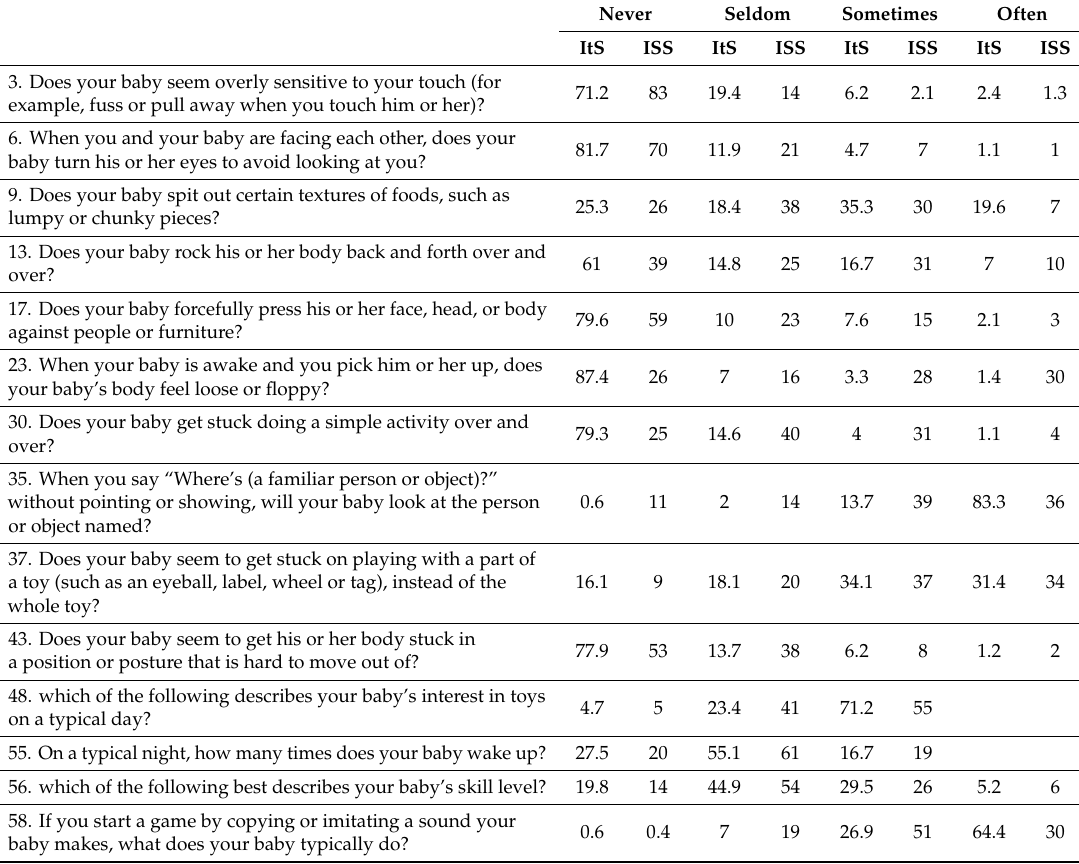
Table 4. Chi-square comparison between Italian (ItS) and Israeli (IS; Ben-Sasson and Carter, 2012) sample response distribution